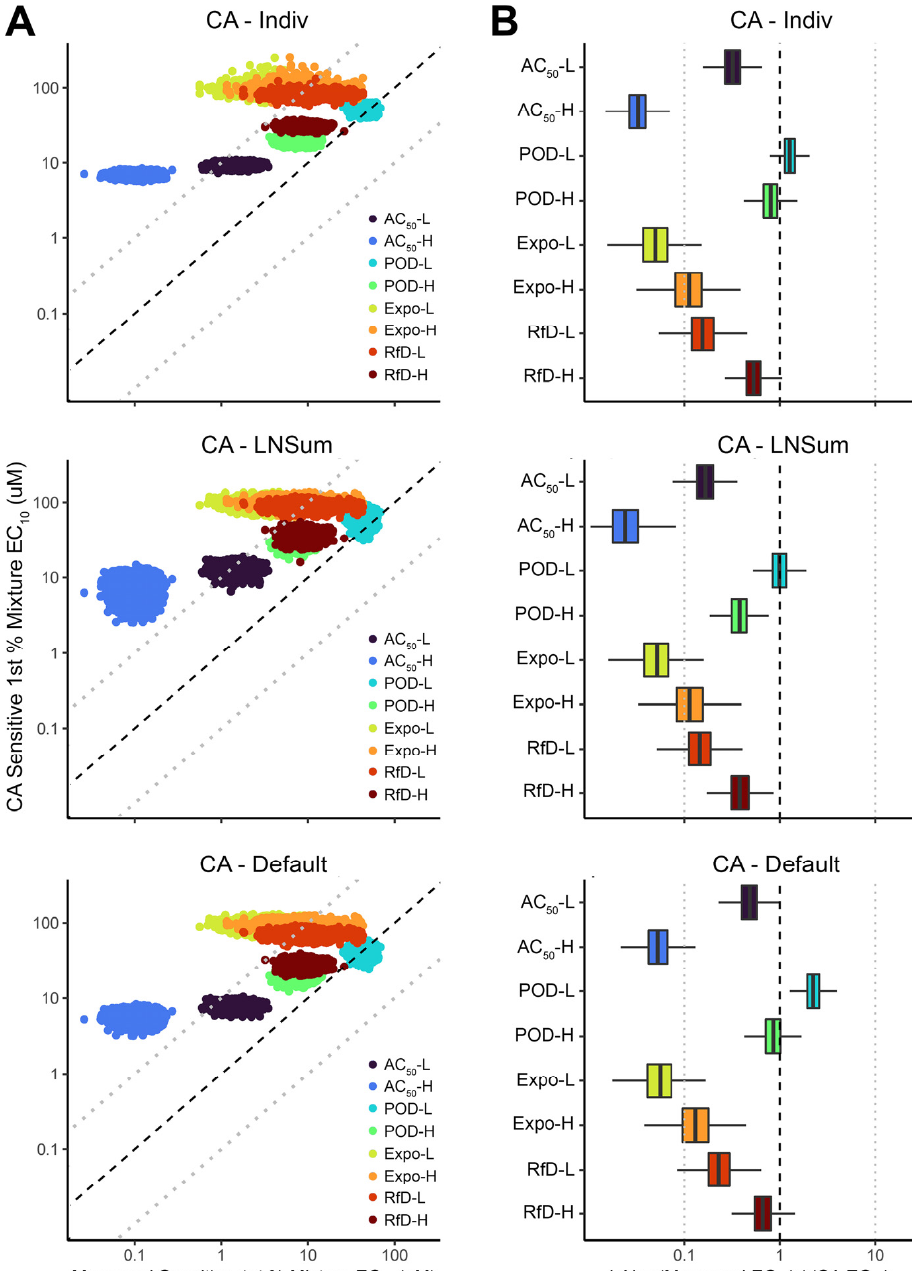
Figure 4. Comparison of mixture points of departure (POD = EC 10 ) measured and predicted by different concentration addition (CA) approaches for sensitive (1st percentile) individual in the population. ( A ). Scatter plot of Bayesian posterior samples of measured and CA-predicted EC 10 for the population’s 1st percentile individual. ( B ). Posterior distribution of Loewe Additivity Index (LAI) for each mixture for the population’s 1st percentile individual, where LAI < 1 indicates greater-than-additive effects (“synergy”) and LAI > 1 indicates less-than-additive effects (“antagonism”). In both panels, dashed line indicates equality, and light dotted lines indicate 10-fold differences in either direction. See Section 2 and Figure 1 for details as to different CA approaches CA Indiv , CA LNSum , CA Default .